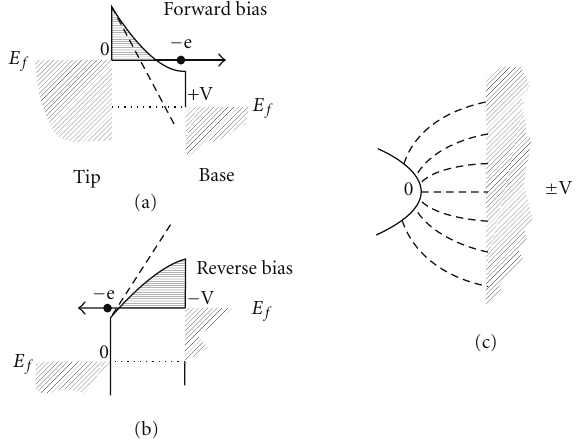
Figure 6: A tunnel barrier of a materially symmetric junction for a geometrically asymmetric junction shown in (c) exhibits a concave shape for forward bias (a) and convex shape for reverse bias (b)